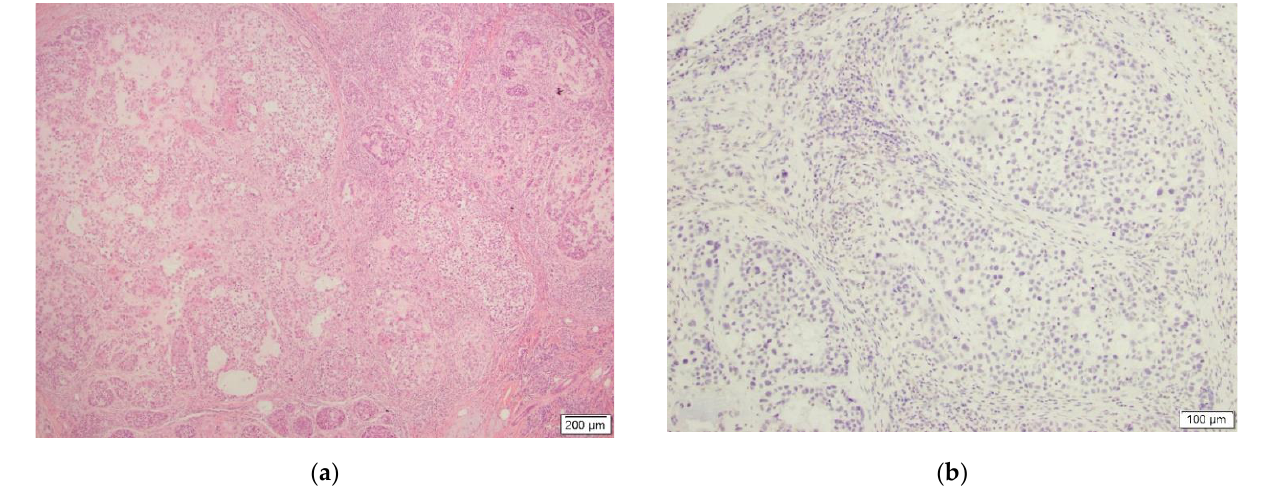
Figure 3. This figure depicts malignant chondroid syringoma (( a ), H&E, 4 × , case #13) and negative TFE3 IHC staining (( b ), TFE3, 10 ×